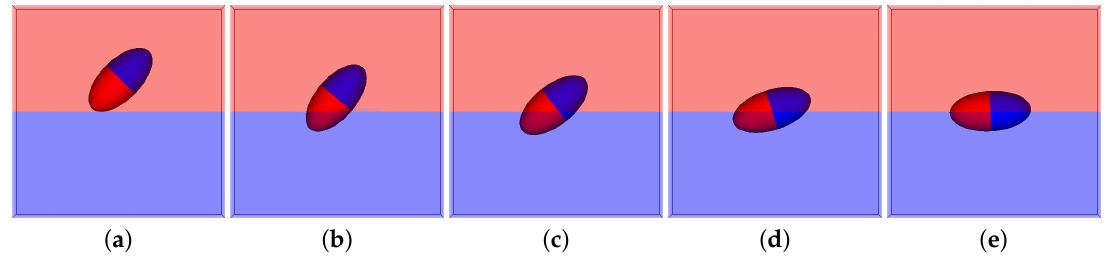
Figure 6. Snapshots of the adsorption process of an ellipsoidal Janus particle at a fluid–fluid interface as obtained from our simulations. The insets ( a – e ) correspond to different timesteps of the simulation, where ( a ) depits the initial and ( e ) the final state.